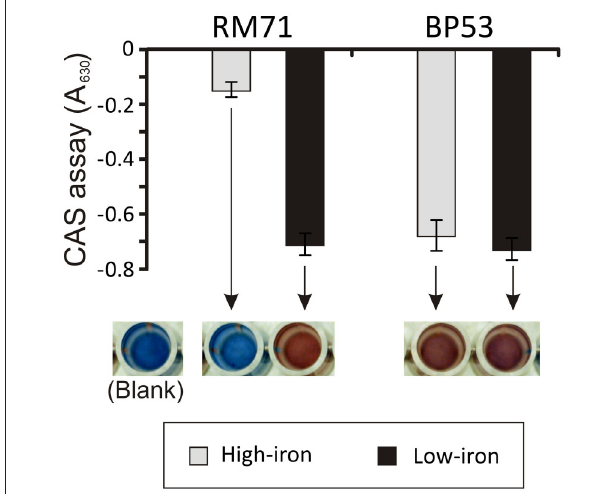
FIGURE 3 | Extracelular citrate accumulation and CAS reactivity in cell free supernatants after growing Pdd strains under iron-excess or iron-deficient conditions. Vibrio anguillarum RV22 and E. coli K12 were used as controls. CAS reactivity of E. coli K12 is due to enterobactin production. Each bar represents mean values from three replicates. Error bars indicate standard deviations.